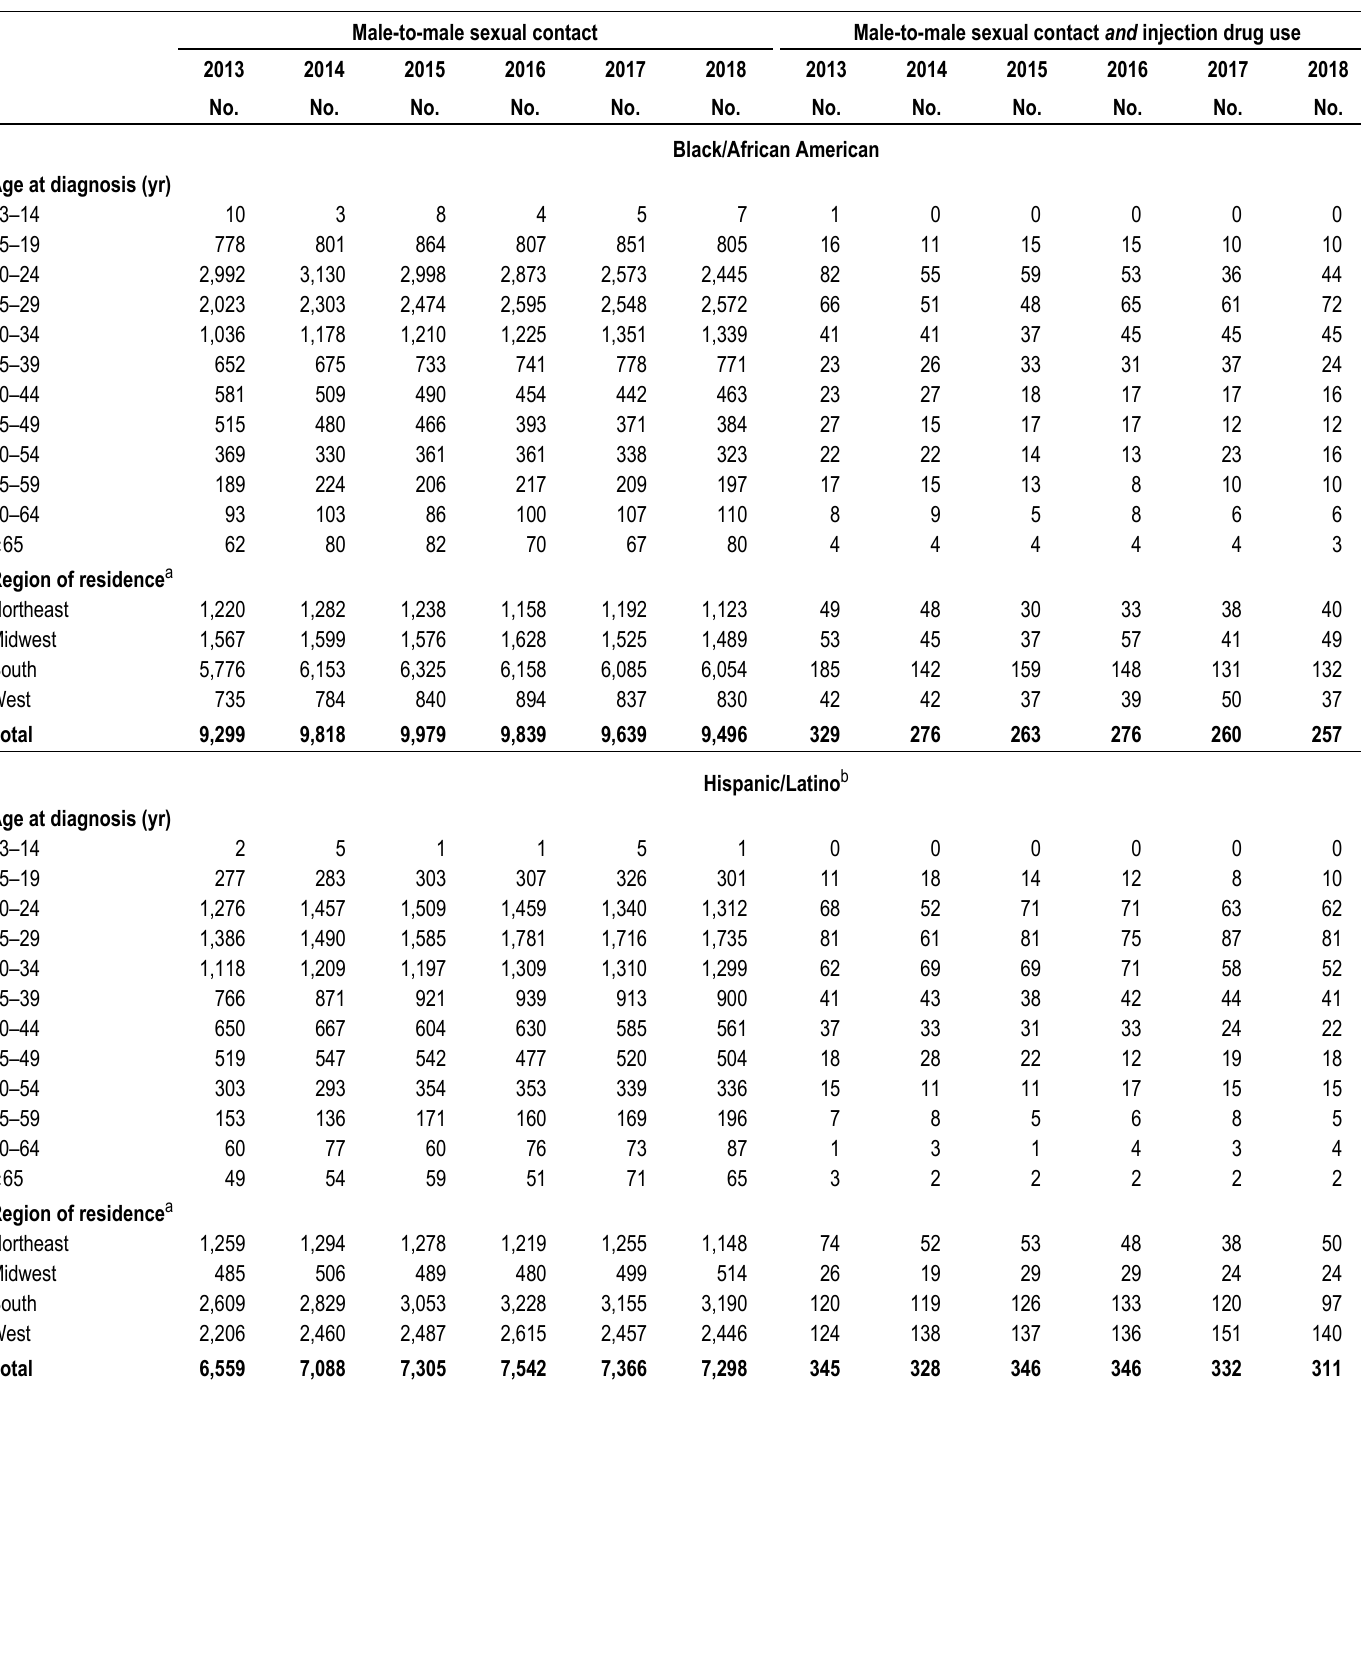
Table 7a.Diagnoses of HIV infection attributed to male-to-male sexual contact and male-to-male sexual contact and injection drug use, by selected characteristics, 2013–2018—United States (cont) Male-to-male sexual contact Male-to-male sexual contact and injection drug